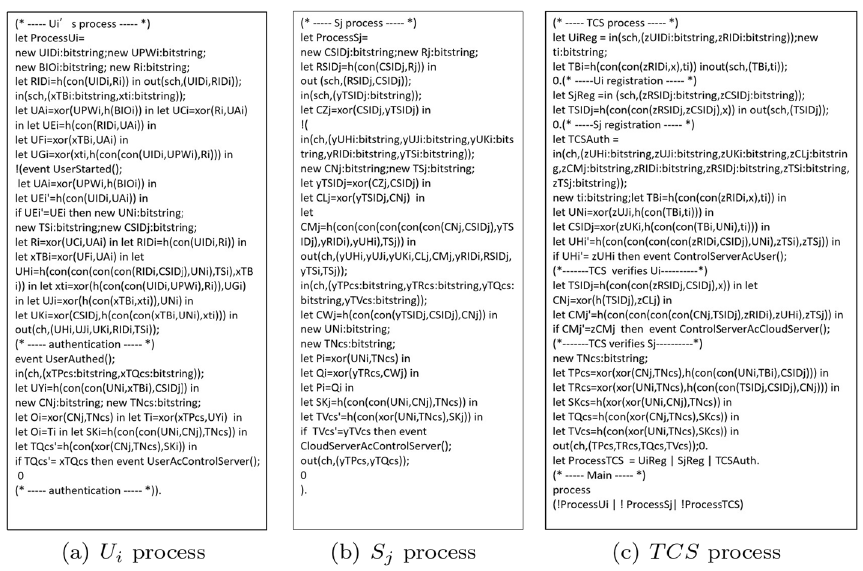
Fig. 5 Execution process of U i , S j ,